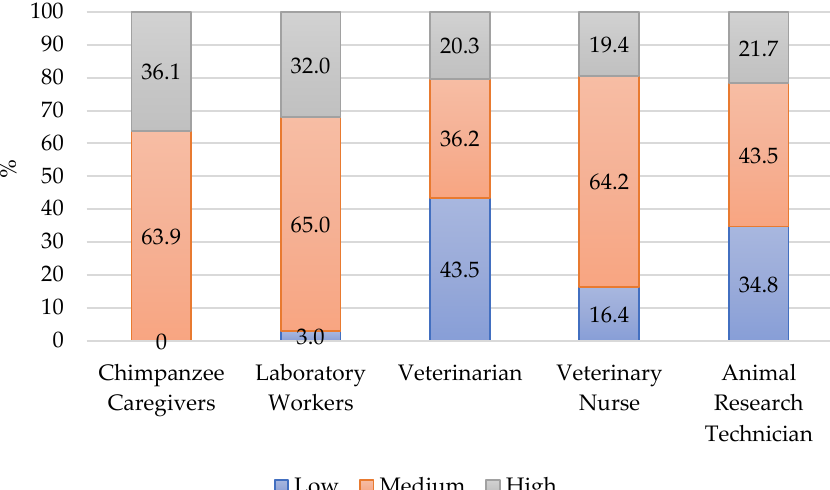
Figure 1. Percent of respondents in each category for CS. Laboratory Workers (N = 170) [21], Veterinarian (N = 69) [12], Veterinary Nurse (N = 23) [12], Animal Research Technician (N = 23) [12].